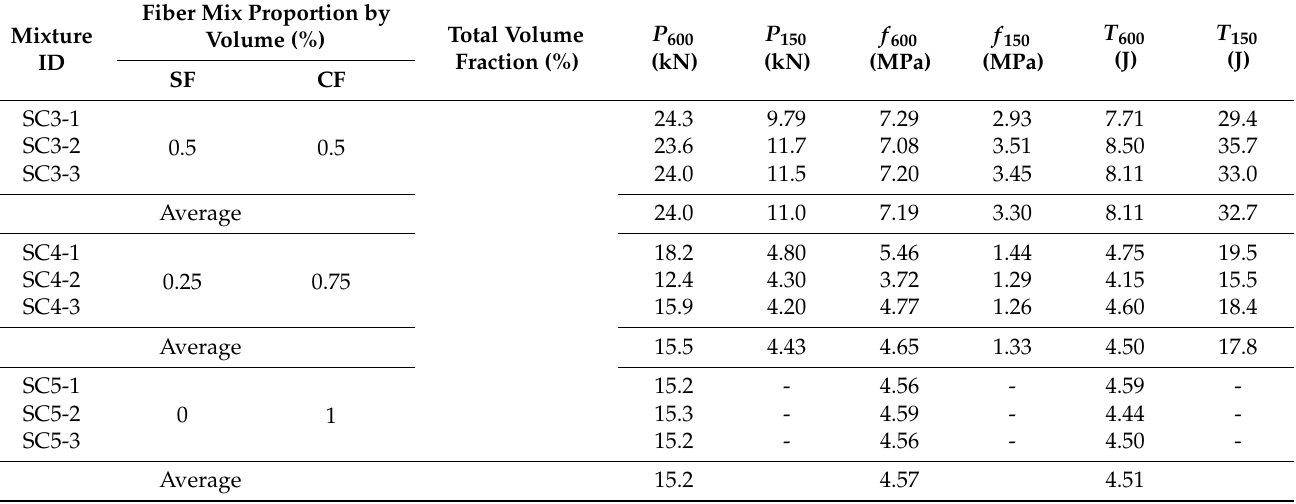
Figure 8. Variation of calculation results of ( a ) equivalent flexural strength, and ( b ) residual flexural strength.